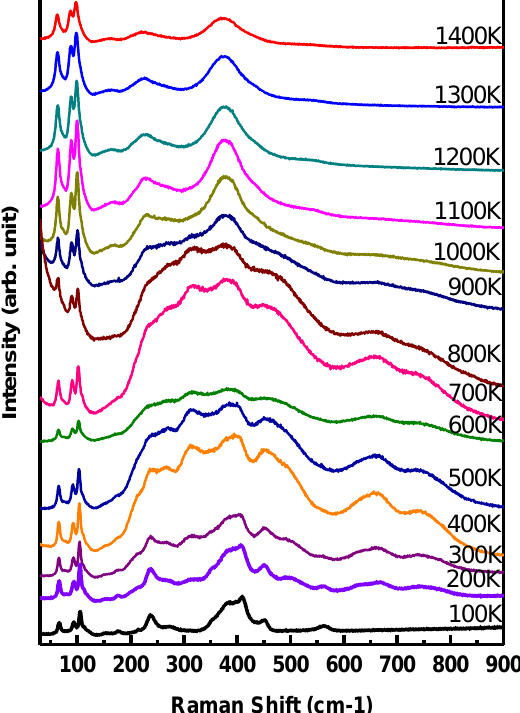
Figure 3. Thermal evolution of the Raman spectra of LaGdO 1400 K, with 10 mW of power at a 514.5-nm laser wavelength, an exposure time of 30 s and at least three recordings of each spectrum. Reprinted with permission from